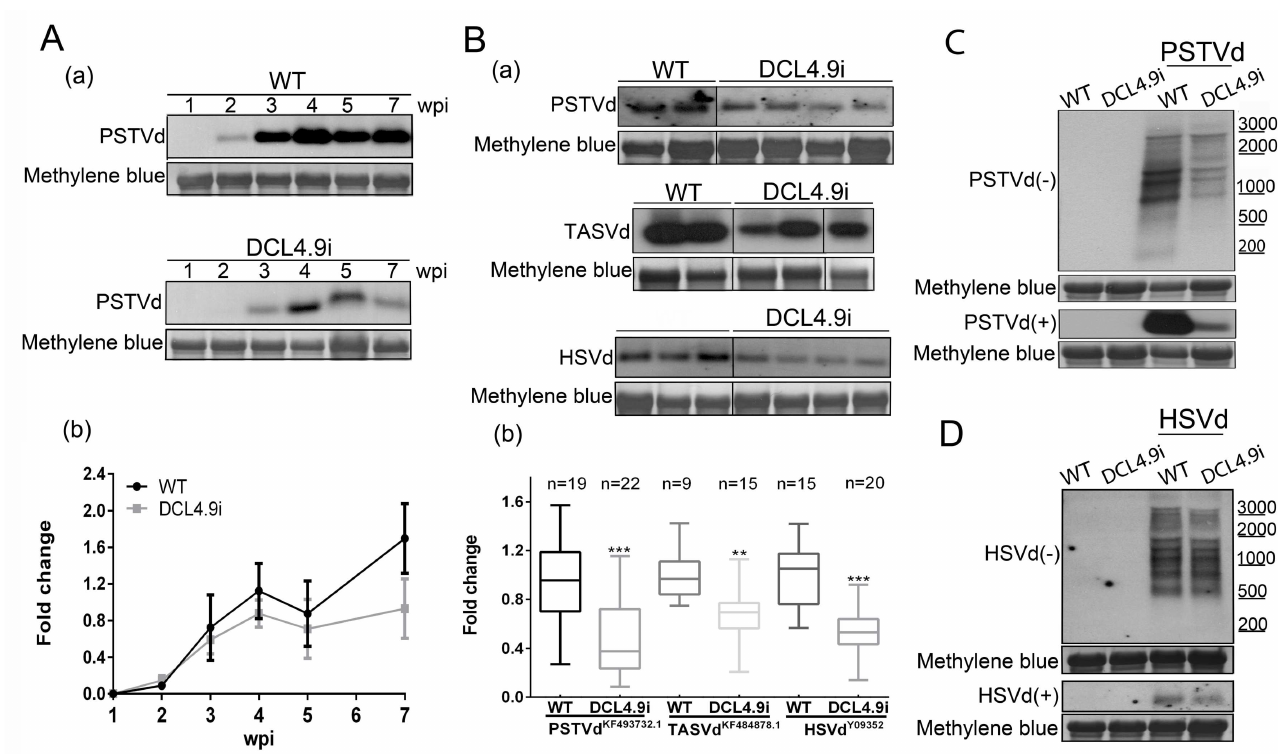
Fig 1. Further analysis of Pospoviroidae infections in DCL4i plants. (A) Time course of PSTVd infection in WT and DCL4.9i plants. Three plants were tested and a representative northern blot is presented. (B) Infections of WT and DCL4.9i plants with PSTVd KF493732.1 , TASVd KF484878.1 (both at 5wpi) and HSVd Y09352 (3wpi). (C) Detection of (-) and (+) strand RNAs of PSTVd in WT and DCL4.9i plants and of HSVd in the same plants (D). In all northern blots, total RNA staining (methyleneblue) was used as loadingcontrol. Quantification of northern blots was performed with Quantity One 4.4.1. Graphical representation and statistical analysiswith Graphpad Prism 6 are presented in (b). ‘n’ corresponds to the number of individualplants tested. Results were analyzedwith unpairedStudent t -test, and the level of significance was set as p < 0.01( ** ) and p < 0.001 ( *** ).